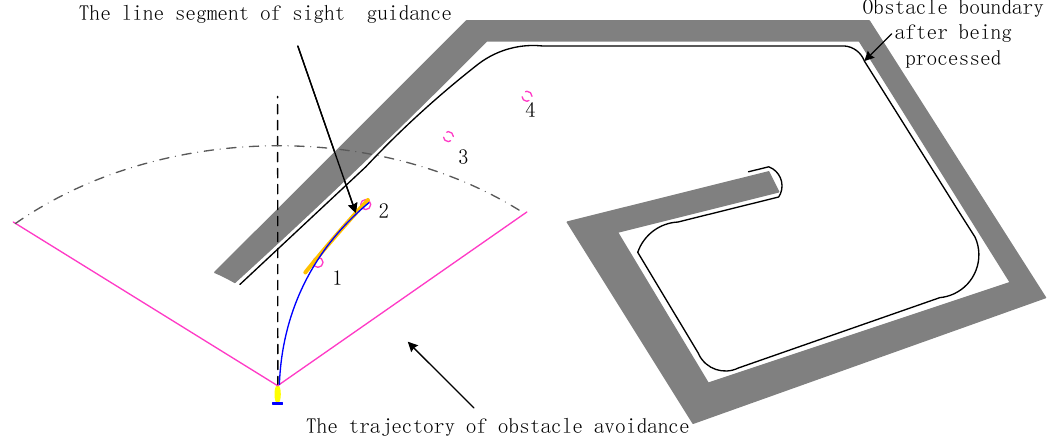
Figure 11. Path design for the obstacle of the vortex obstacle.